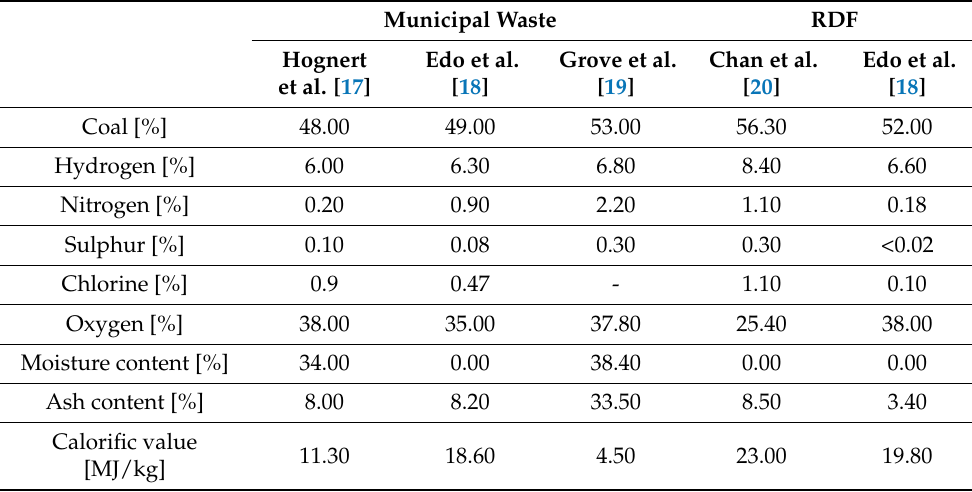
Table 2. Selected properties of municipal waste and